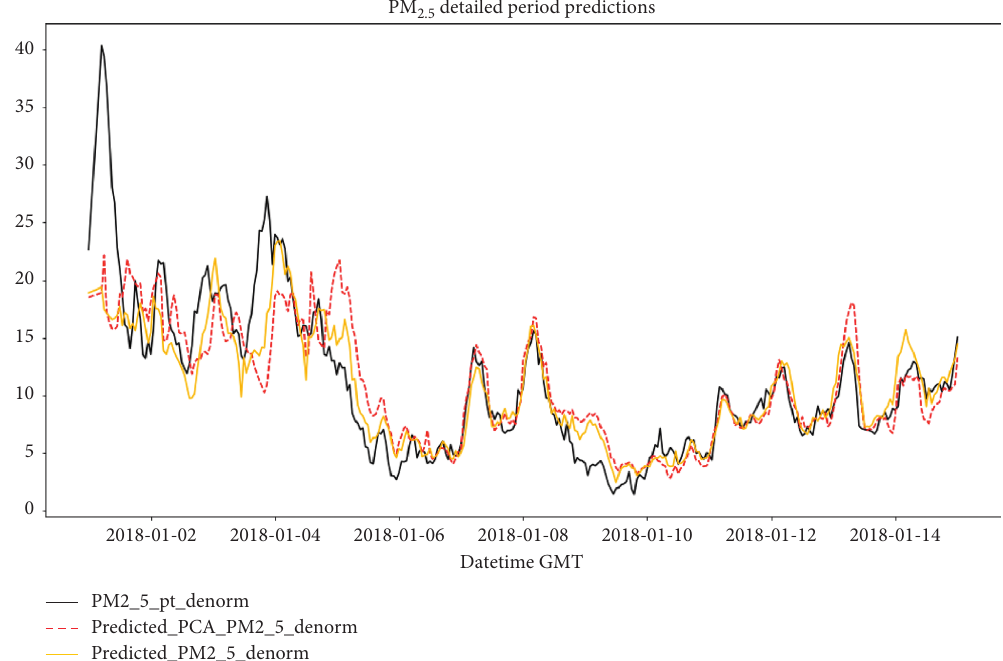
Figure 18: Observed and predicted particulate matter 2.5 values for the period between January 1 st and January 15 th